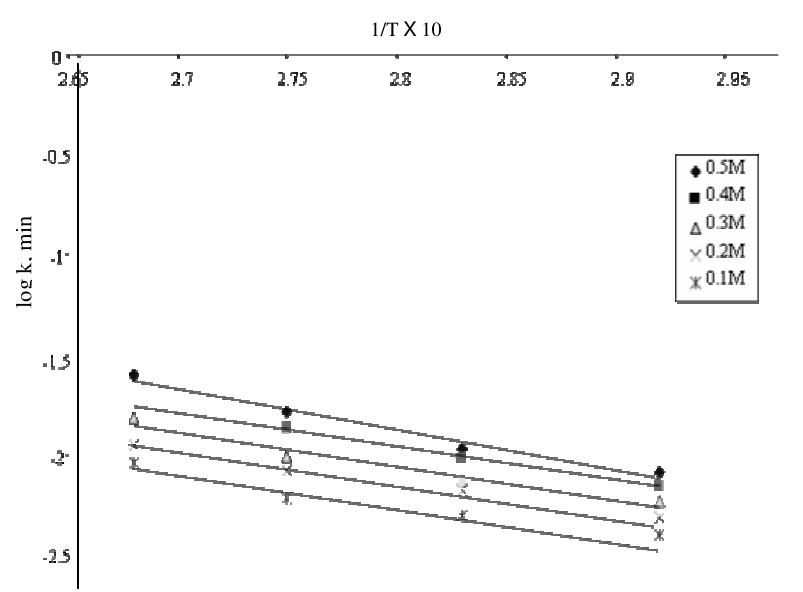
Figure 3 . Arrhenius plots for nicardipine HCl at different concentrations of NaOH. Table 3. Effect of temperature on the kinetic parameters of nicardipine HCl (40 µ g/mL) at different concentrations of sodium